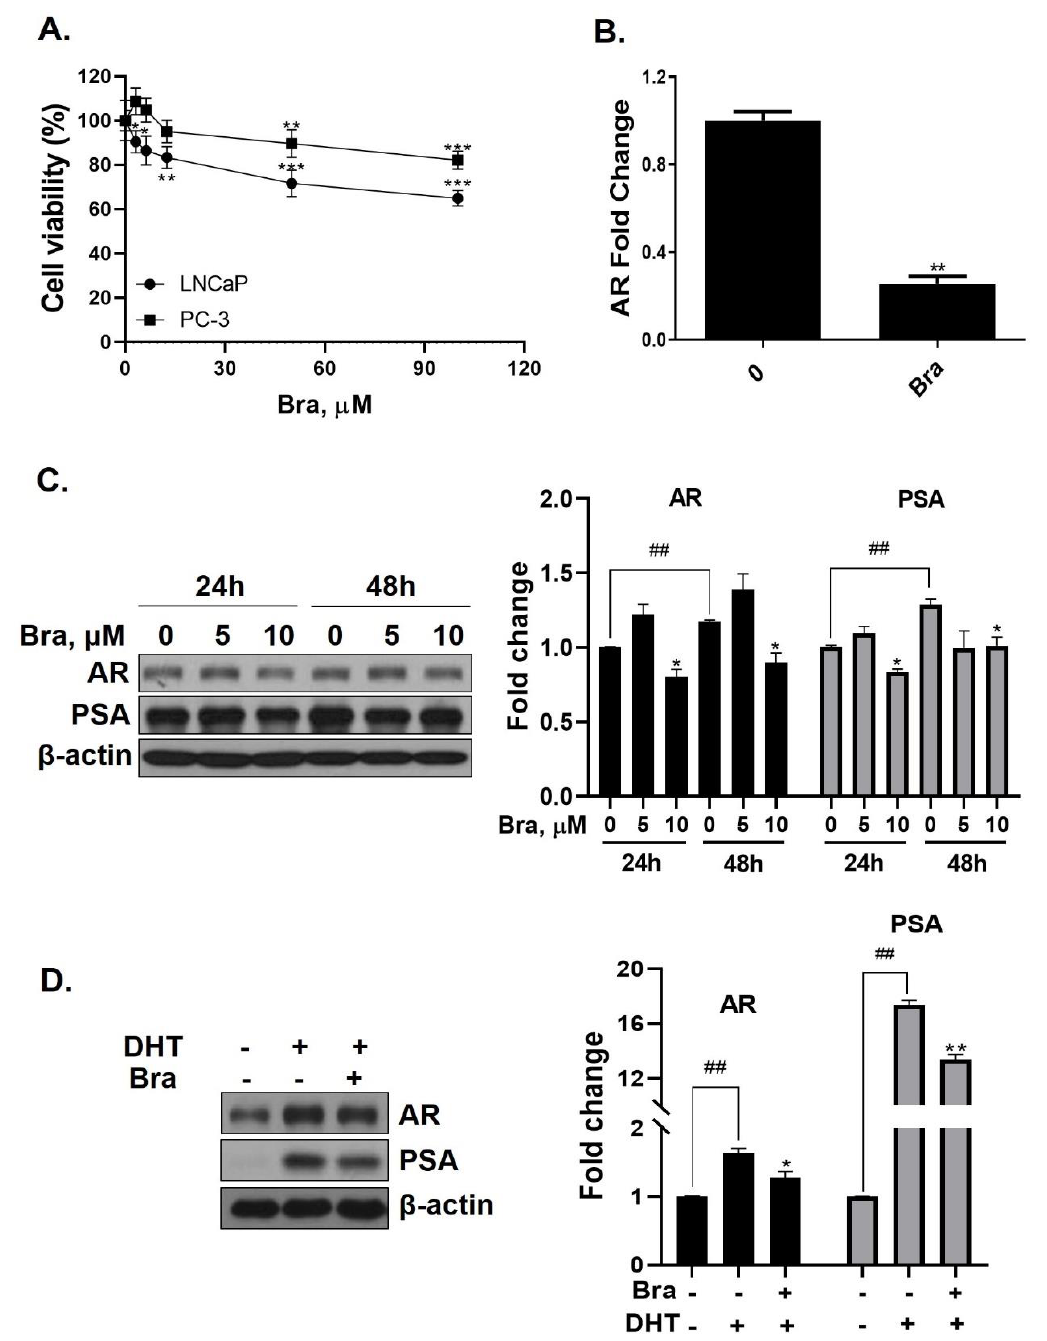
Figure 3. Inhibitory e ff ect of brassicasterol on AR and PSA expression in LNCaP cells. ( A ) Cell viability assay. LNCaP and PC-3 cells were treated with various concentrations of brassicasterol for 24 h. (*) p < 0.05, (**) p < 0.01, and (***) p < 0.001 (in comparison to control). ( B ) LNCaP cells were treated with 10 µ M brassicasterol for 24 h. AR mRNA levels using qRT-PCR. Quantitative mRNA levels are shown. (**) p < 0.01 (in comparison to control). ( C ) Changes of the AR and PSA expression in LNCaP cells by treatment with brassicasterol according to concentration and time. Bar graph represents the quantification of interest protein related to β -actin, presents as a fold change of control. (*) p < 0.01 (in comparison to control of each time) (##) p < 0.01(in comparison to 24h control). ( D ) Changes of AR and PSA expression in DHT-induced LNCaP cells by treatment with brassicasterol. Bar graph represents the quantification of interest protein related to β -actin, presents as a fold change of control. (*) p < 0.05, (**) p < 0.01 (in comparison to DHT-stimulated control) (##) p < 0.01 (in comparison to